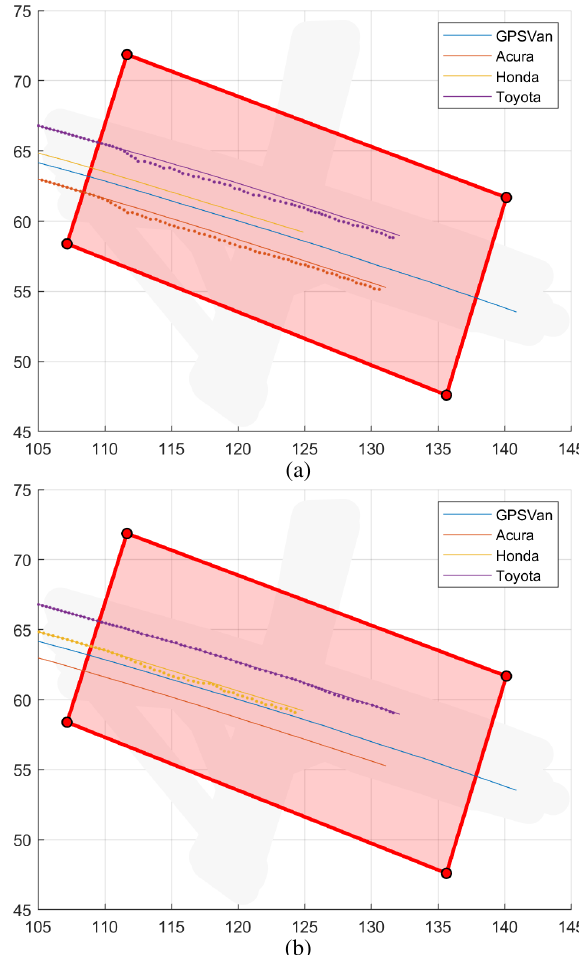
Figure 6. Reference (solid lines) and estimated (circular marks) vehicle tracks in case study 1a (a), and 1b (b).